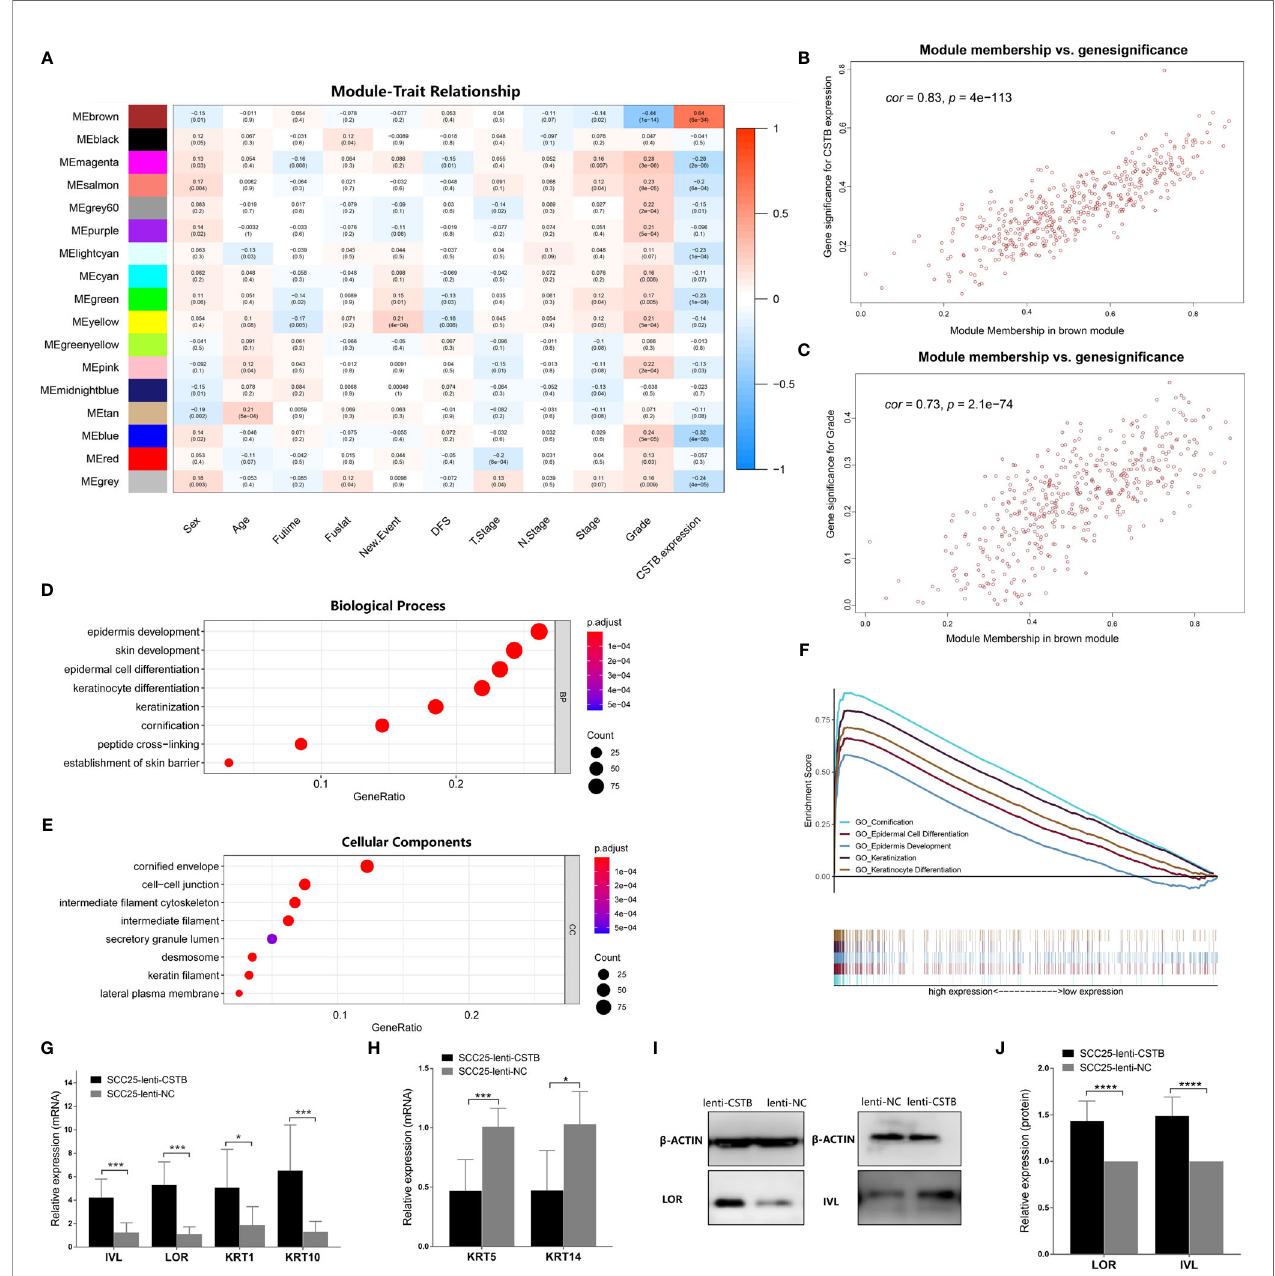
FIGURE 4 | CSTB may regulate epithelial cell differentiation and keratinization in OSCC. (A) Heatmap of the correlation between module eigengenes (vertical axis) and clinical features (horizontal axis). The correlation coef fi cient (upper row) and p -value (lower row) are presented in each block. The color of each block represents the correlation coef fi cient according to the legend axis on the right. (B) Scatter diagram for the correlation between module membership and the gene signi fi cance of CSTB expression in the brown module. Cor , correlation coef fi cient; p , p -value. (C) Scatter diagram for the correlation between module membership and gene signi fi cance of grade classi fi cation in the brown module. Cor , correlation coef fi cient; p , p -value. (D, E) GO enrichment analysis of the brown module genes. (F) Squamous epithelial keratinization- and differentiation-related pathways with statistically signi fi cant differences in GSEA using KEGG enrichment analysis. (G, H) Relative mRNA expression of cell differentiation and keratinization-related markers in OSCC cell lines after lentivirus transfection. (I, J) Protein expression of cell differentiation and keratinization-related markers in OSCC cell lines after lentivirus transfection. Error bars represent the standard deviation. * p < 0.05, ** p < 0.01, *** p < 0.001, **** p <